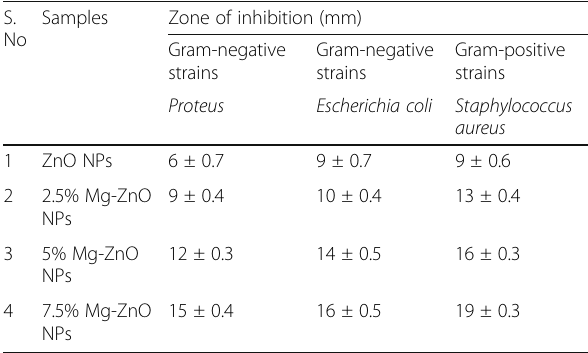
Table 3 Average diameter values of Zones of Inhibition (ZOI) for pure and Mg-doped ZnO NPs (2.5 – 7.5 M %) S. No